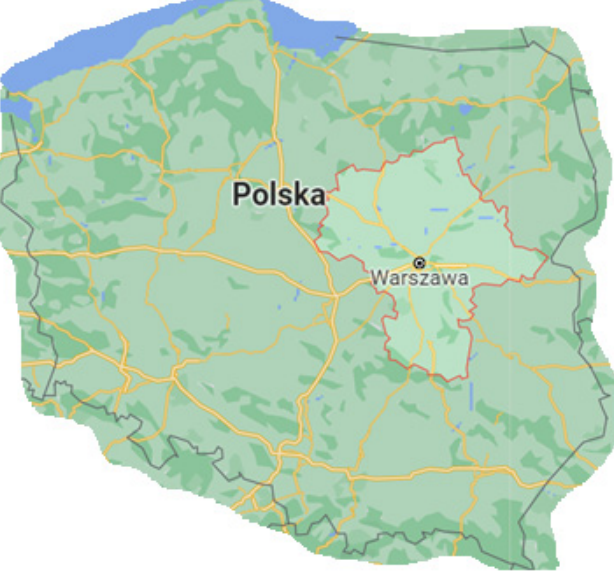
Figure 2. Location of the study performed.